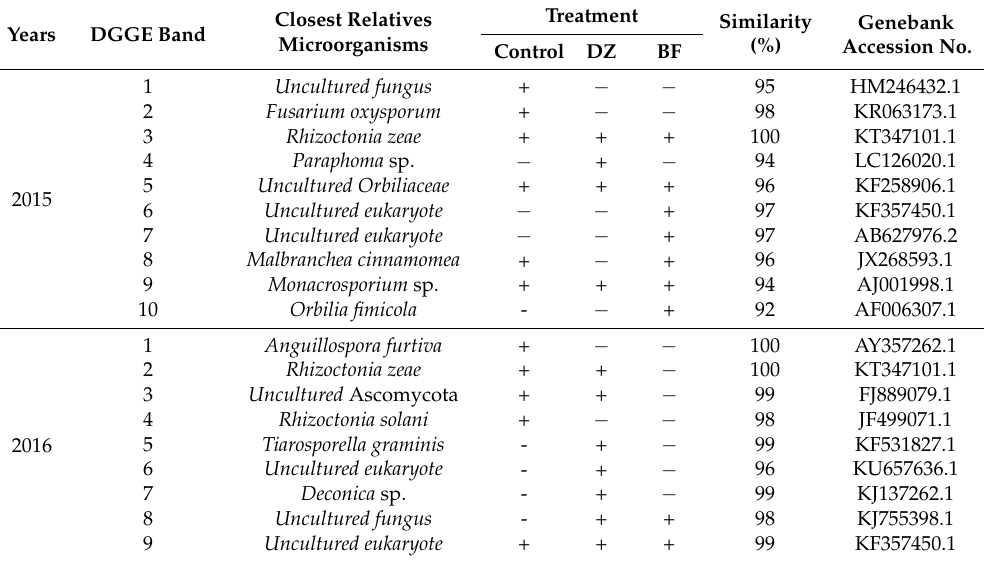
Table 5. Phylogeny of sequences present in the 18S rRNA amplicons